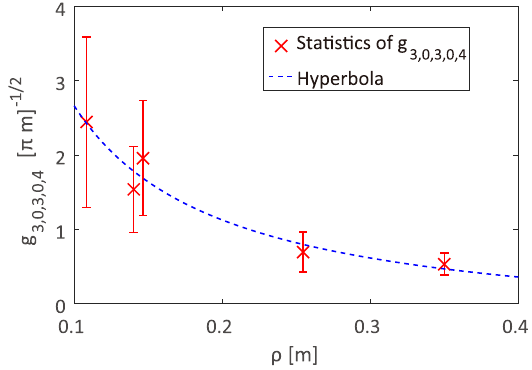
FIG. 5. Resonance strength in cases with different bending radii ρ